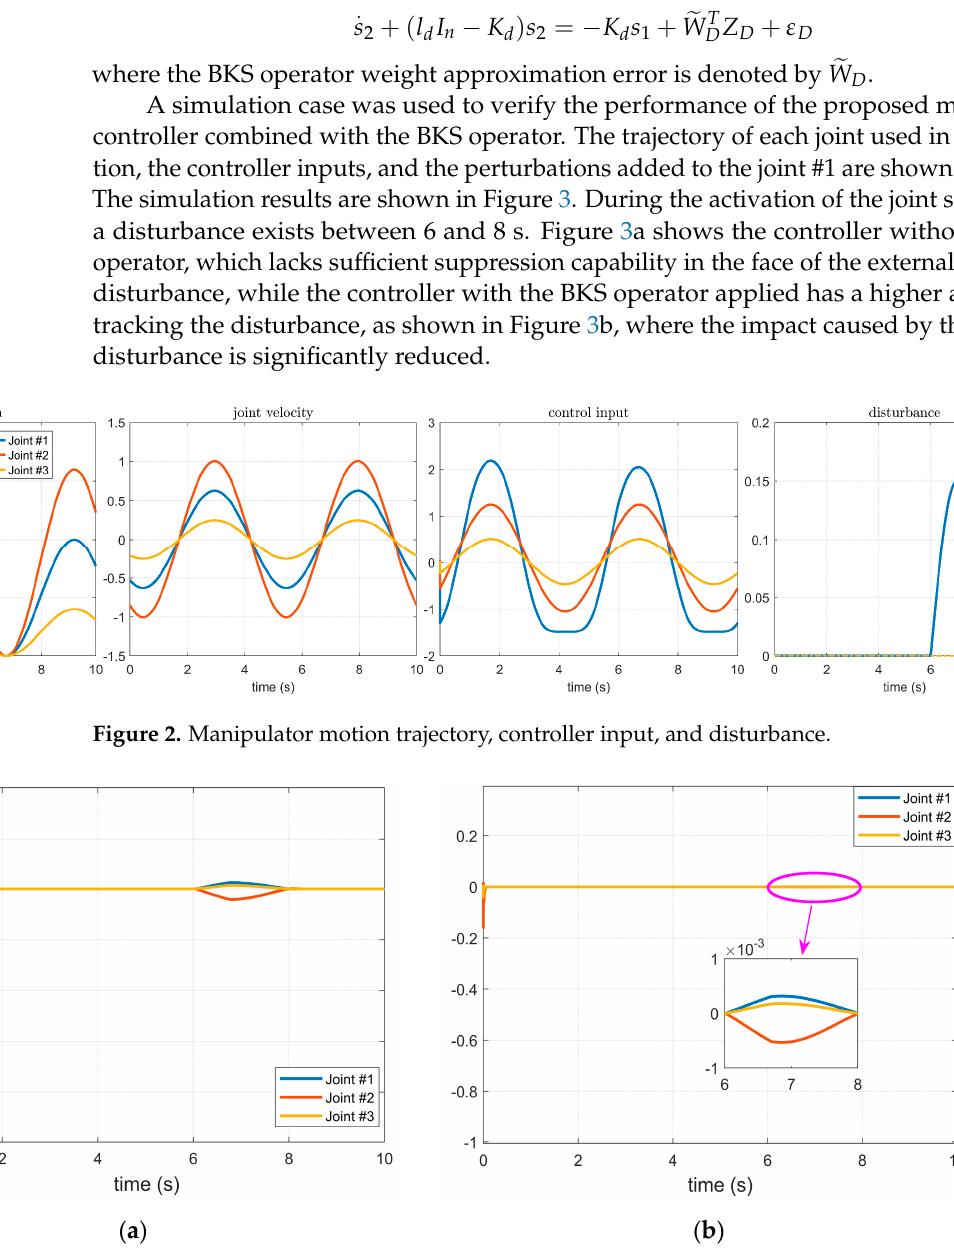
Figure 3. Effect of disturbance on servo motor of each axis of manipulator: ( a ) The BKS operator is not applied; ( b ) The BKS operator is applied.